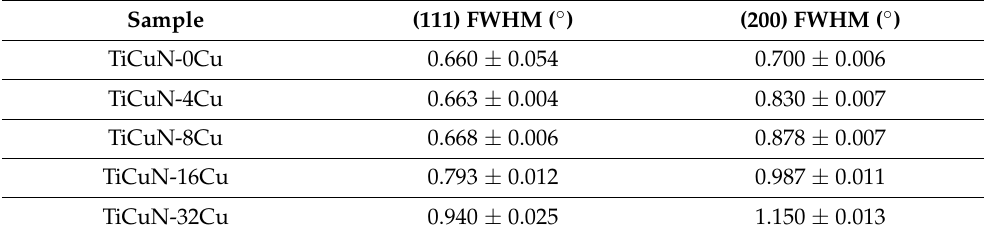
Table 3. Half width and height of TiCuN films with different Cu contents.